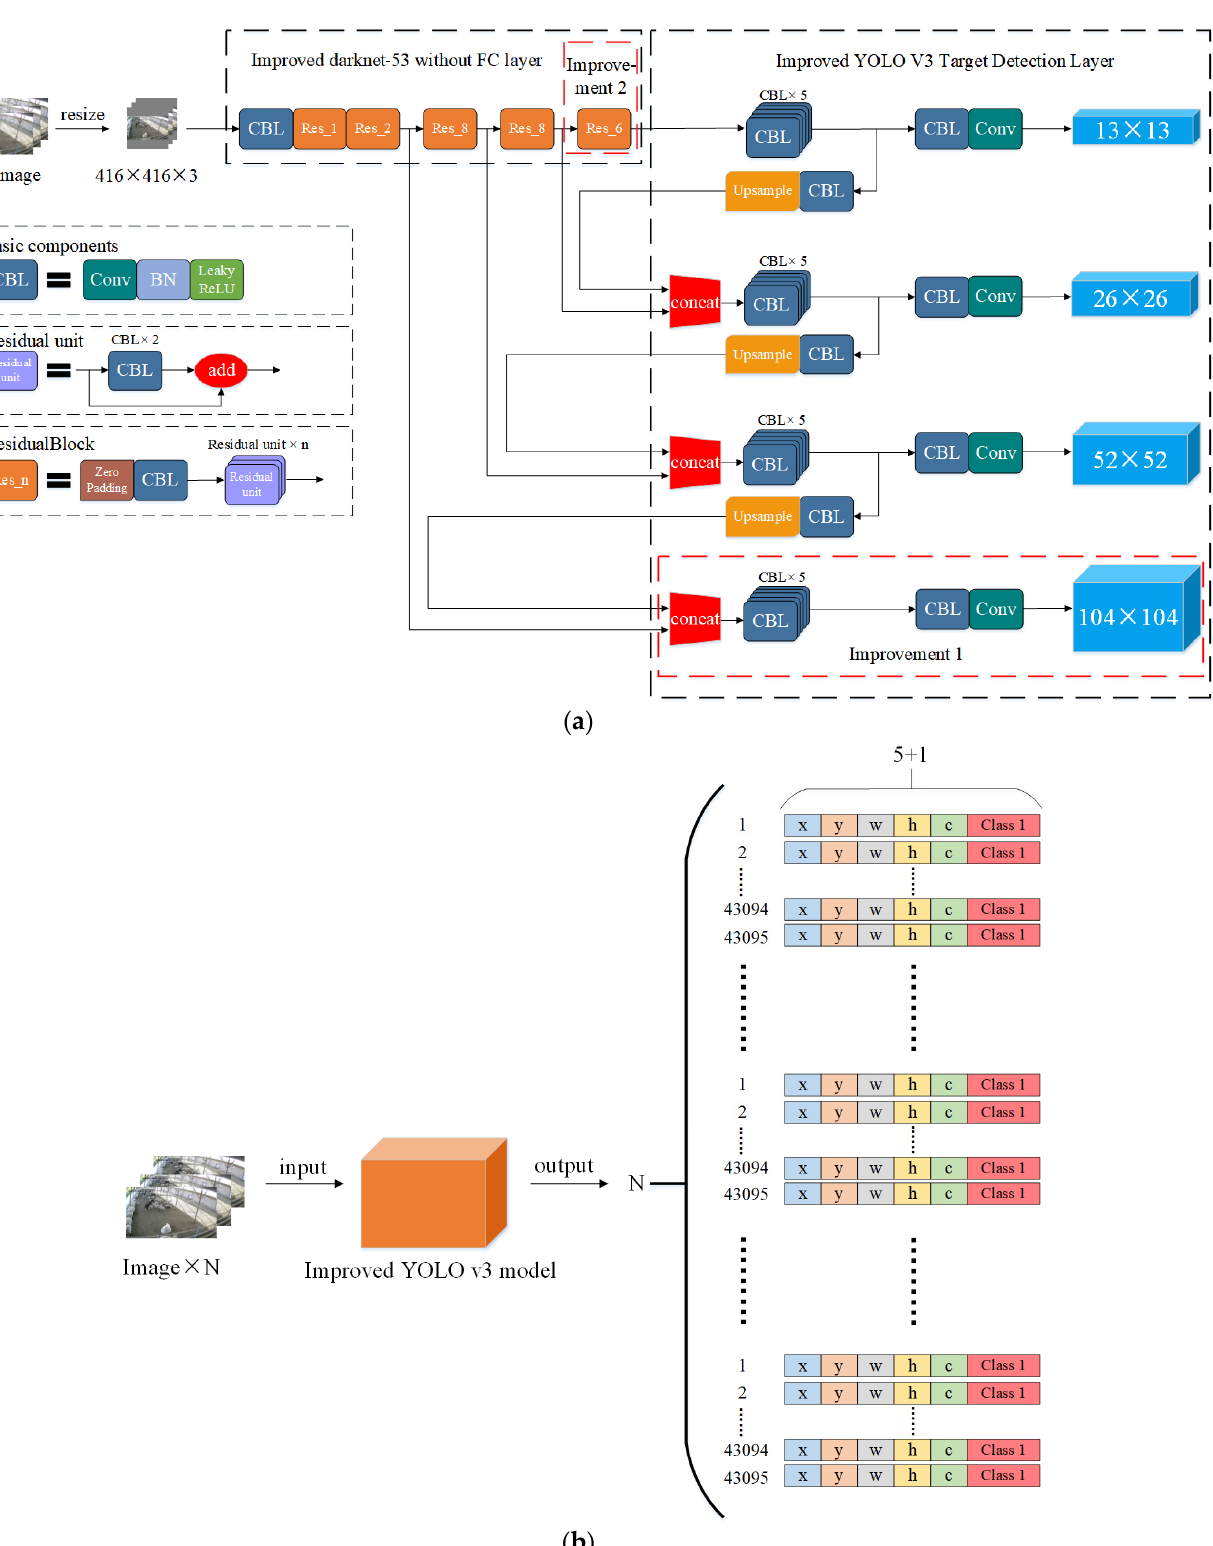
Figure 6. Structure and output of multi ‐ target detection layer network model: ( a ) Structure of multi ‐ target detection layer network model; ( b ) Output of multi ‐ target detection layer network model.